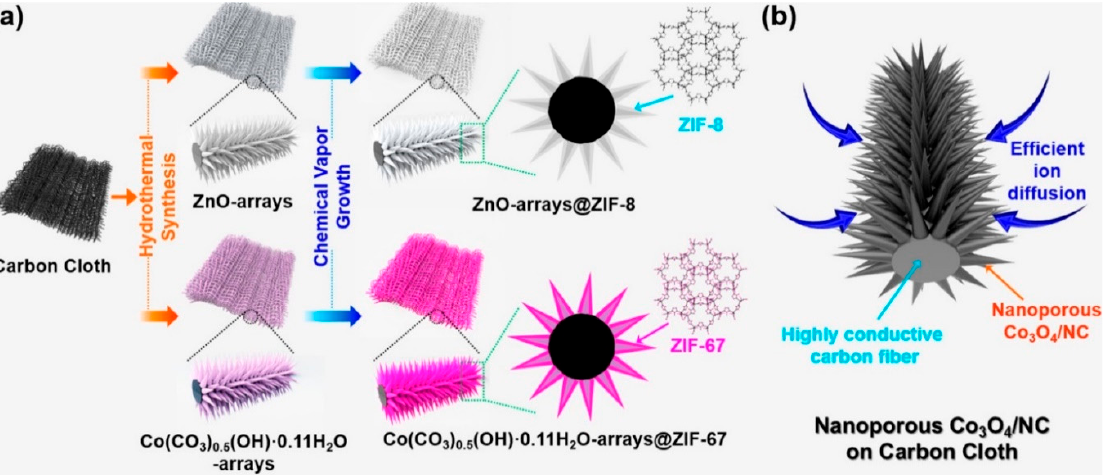
Figure 5. Scheme showing the synthetic process to generate ( a ) ZnO@ZIF-8-x-y and Co(CO 3 ) 0.5 (OH) · 0.11H 2 O@ZIF-67-x-y using 2-Melm vapor, where x and y are the synthesis temperature and synthesis time, respectively. ( b ) Advantages of Co 3 O 4 /NC hybrid materials. Adapted from [34], 2018, American Chemical Society.